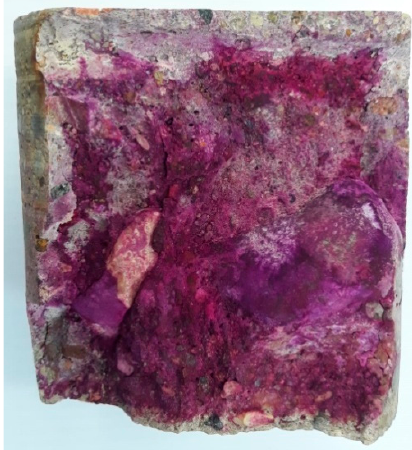
Figure 14. A photograph showing a concrete fracture with a phenolphthalein solution applied.